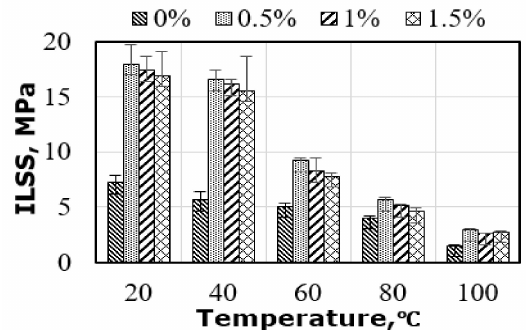
Figure 5. Relationship between temperature and ILSS